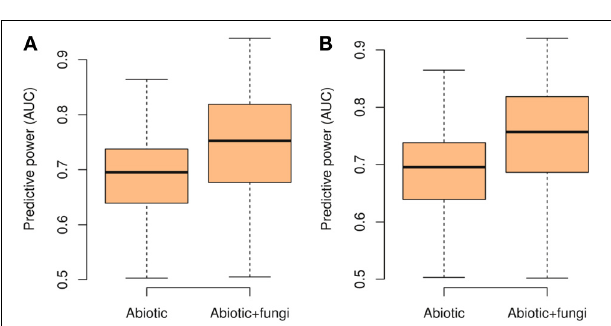
FIGURE 2 | Boxplot of the predictive power of the species distribution models measured with the area under the curve (AUC) when considering only abiotic predictors or additionally including also the number of OTUs of potentially mutualistic fungi. Shown are the results for Glomeromycetes (A) and Agaricomycetes (B) . FIGURE 3 | Relationship between the average elevation where a plant